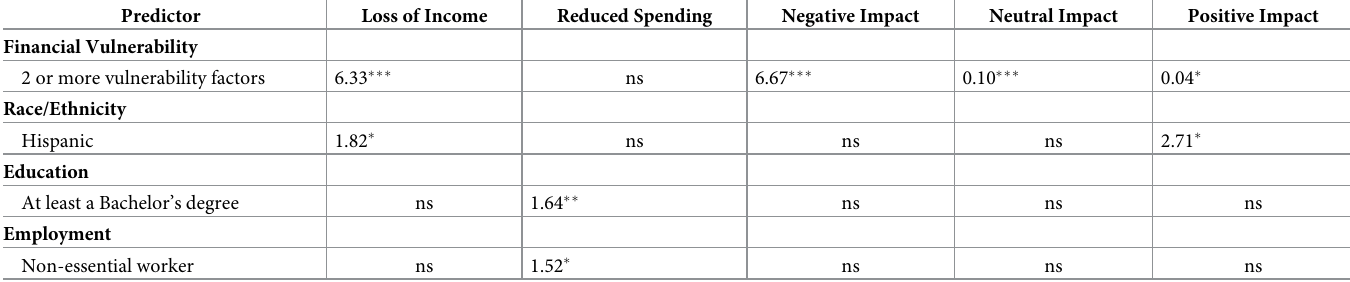
Table 6. Predictors of COVID-19 impact on household finances–financial vulnerability, demographic, health, and employment factors (multivariate logistic